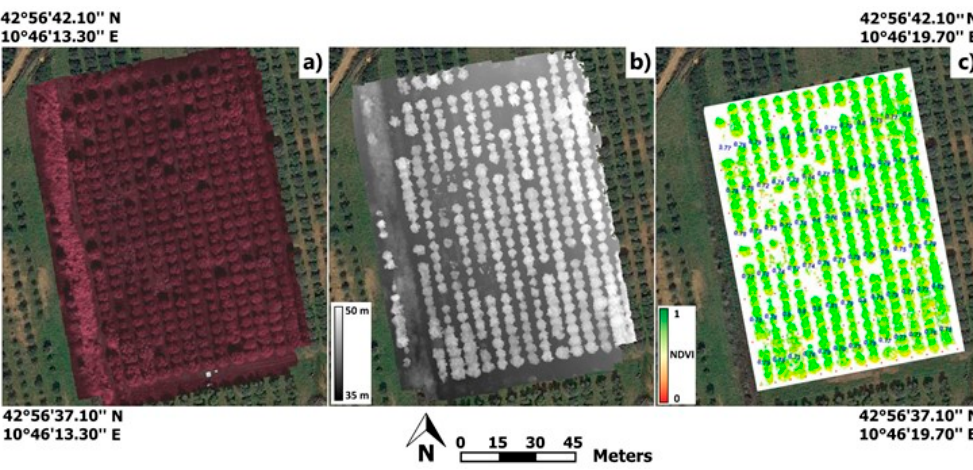
Figure 1. Unmanned aerial vehicle (UAV) image processing flow: ( a ) orthomosaic; ( b ) digital surface model (DSM); ( c ) olive crown vegetation index extraction based on canopy height model (blue numbers provide an example of normalized difference vegetation index extracted per single crown).